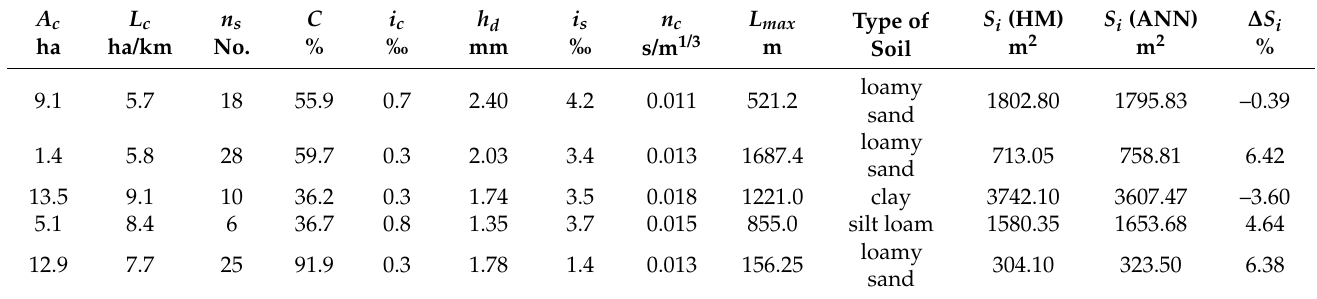
Table A3. Comparison of the required areas of the completely drained infiltration basin ( S i ) generated for a random combination of input parameters from the MLP 12-8-1 artificial neural network (ANN) and those obtained from the hydrodynamic simulations (HM) (designations as in Figure 2).